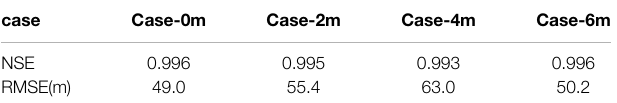
TABLE 2 | NSE and RMSE for each case at